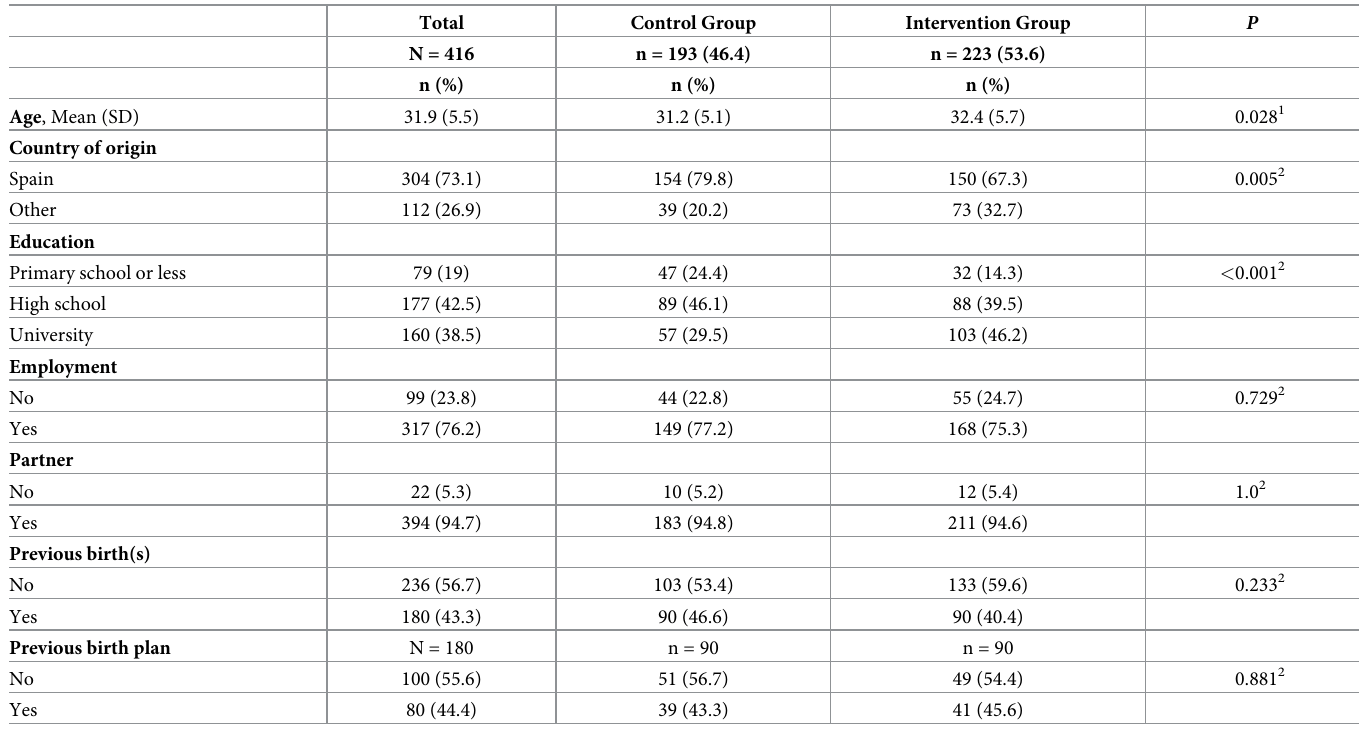
Table 1. Baseline characteristics of the